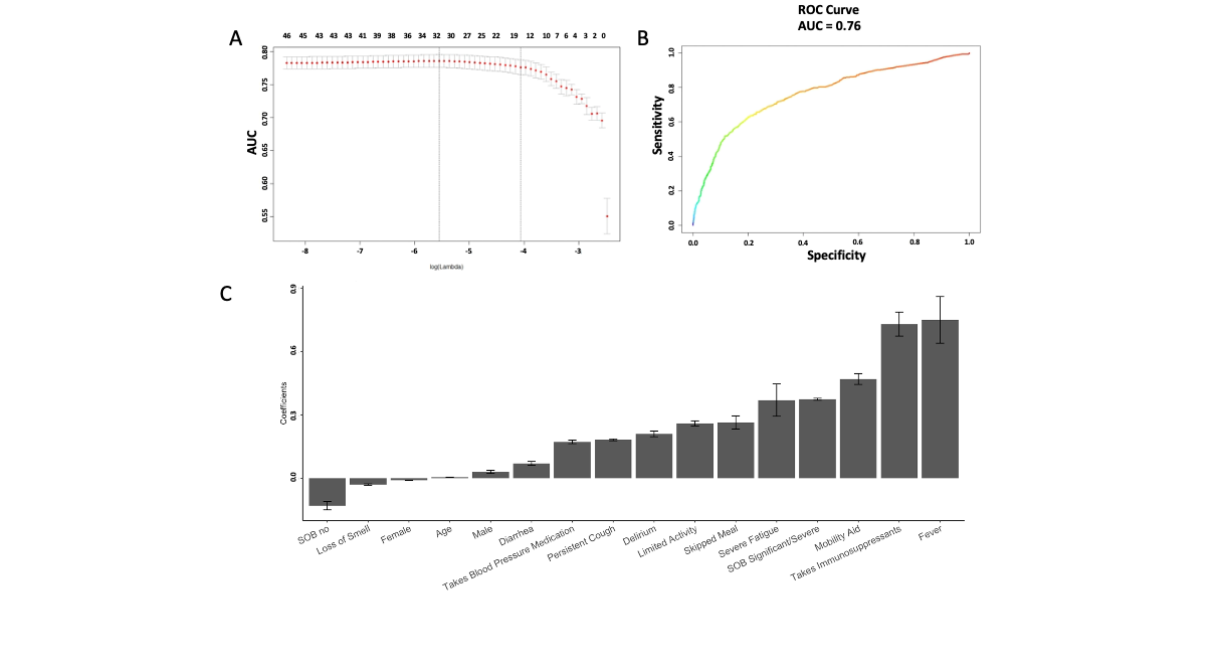
Figure 1. Elastic Net regression predictive performance and selected variables. We used Elastic Net regression where the outcome of seeking treatment or not was regressed on features in Tables 1-4. An example performance in terms of cross-validation AUC for Elastic Net classification on the training set across different values of lambda is shown in the top left. The final set of features selected from the Elastic Net model was applied on a holdout test data set and the resulting AUC is shown in the top right. The most important features selected by the Elastic Net model are shown at the bottom. Negative coefficients indicate a negative association with outcome and vice versa. AUC: area under the receiver operating characteristic curve; ROC: receiver operating characteristic; SOB: shortness of